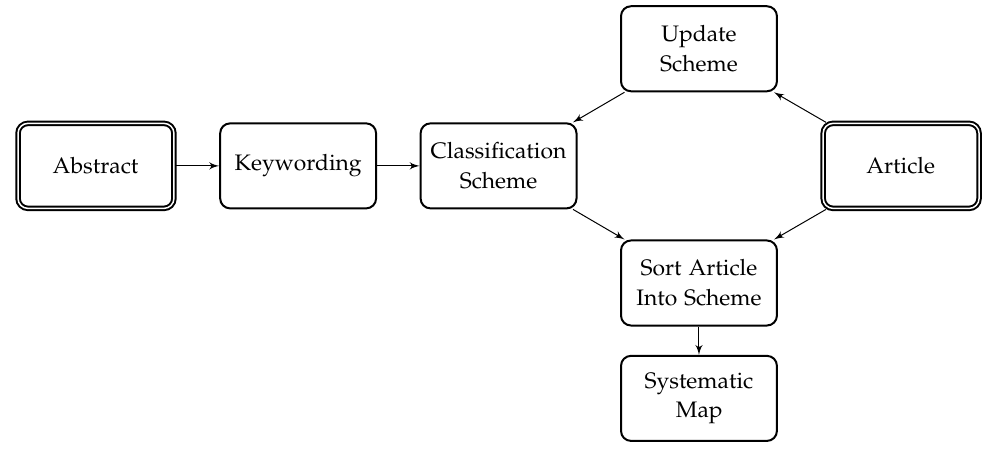
Figure 2. Keywording process approach proposed by